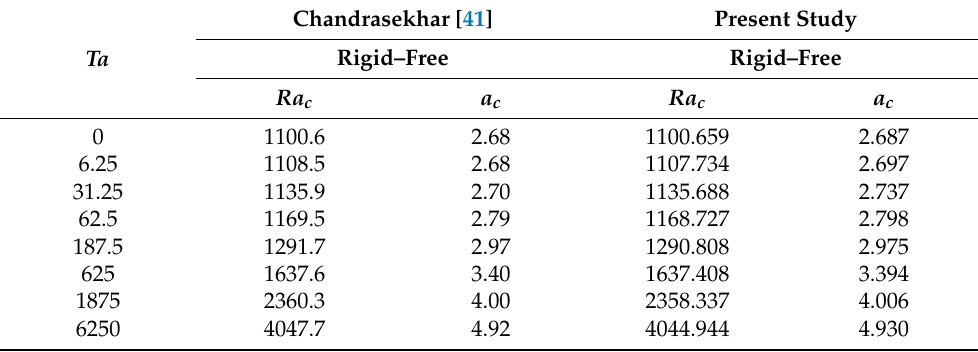
Table 1. Comparison between the present article’s results with existing results for Rigid–Free bound- ary conditions for limiting case of sparsely packed porous